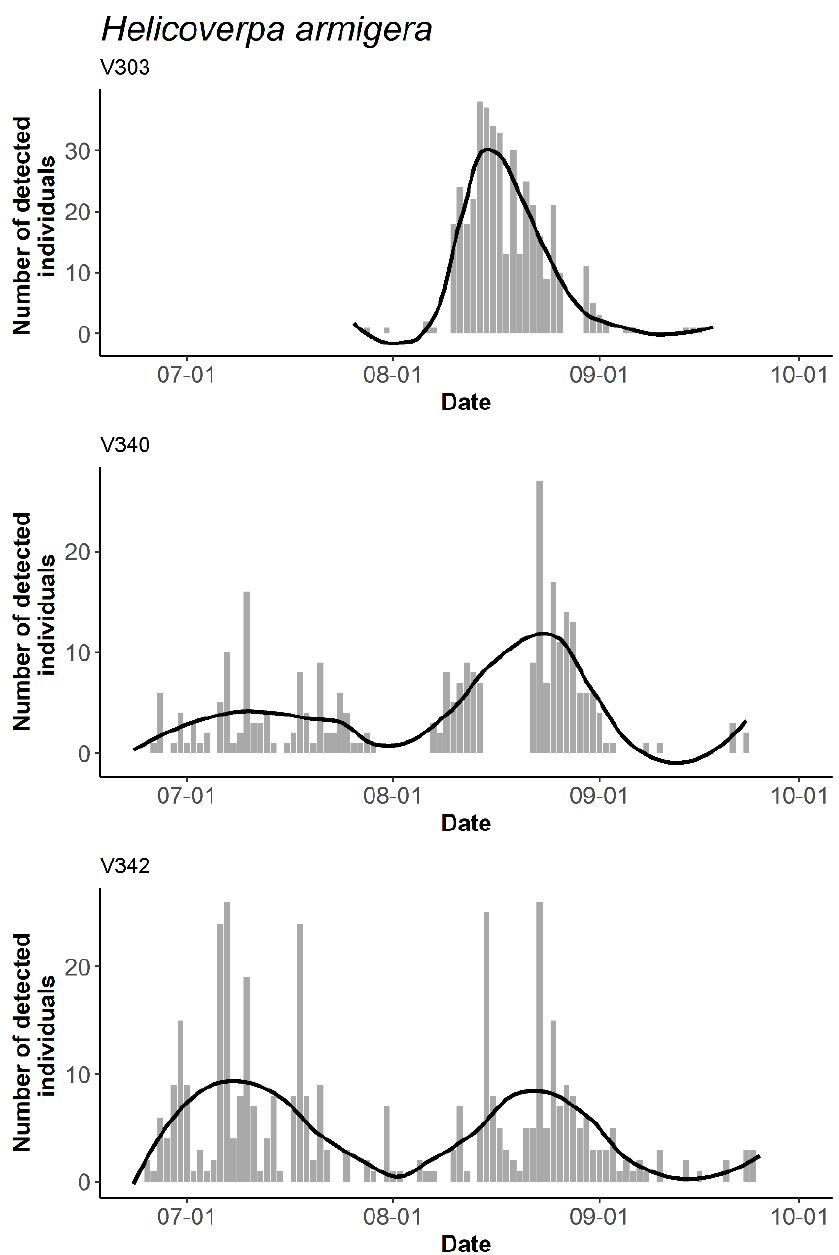
Figure 4. An example of the automatic detection of individuals for target species over time during the monitoring period. The number of detected Helicoverpa armigera individuals from three different probes. Local polynomial regression fitting (loess) was applied for smoothing time-series data.